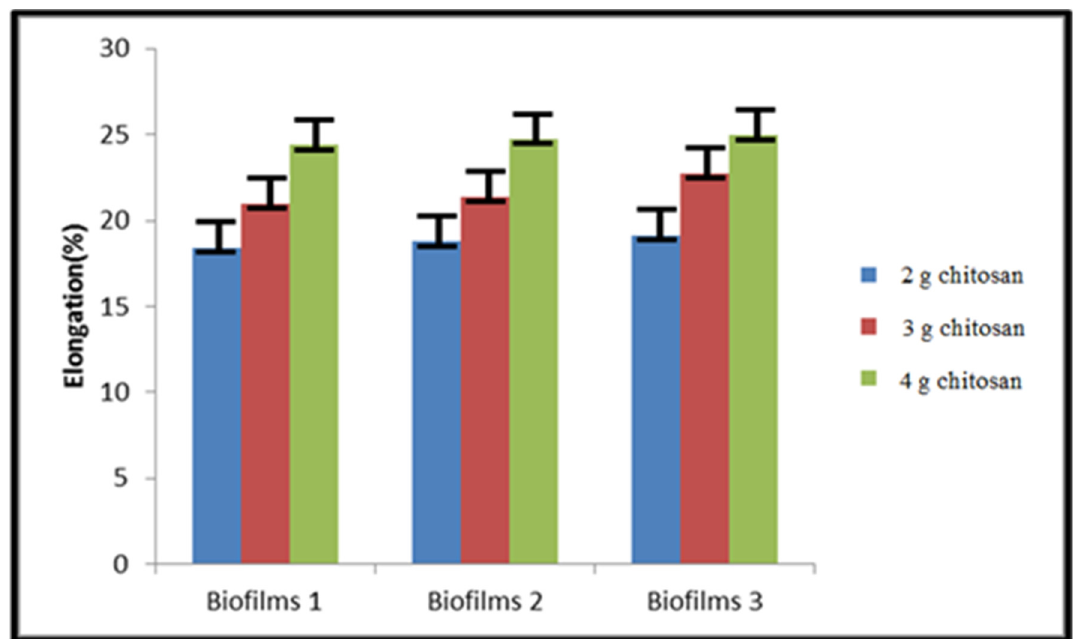
Figure 7. Mean values (±standard deviation) of elongation (%) obtained from biofilm formations of: 2 gr chitosan; 3 gr chitosan; 4 gr chitosan after the elongation test each biofilms. A statistical difference from SPSS is indicated ( p < 0.05).